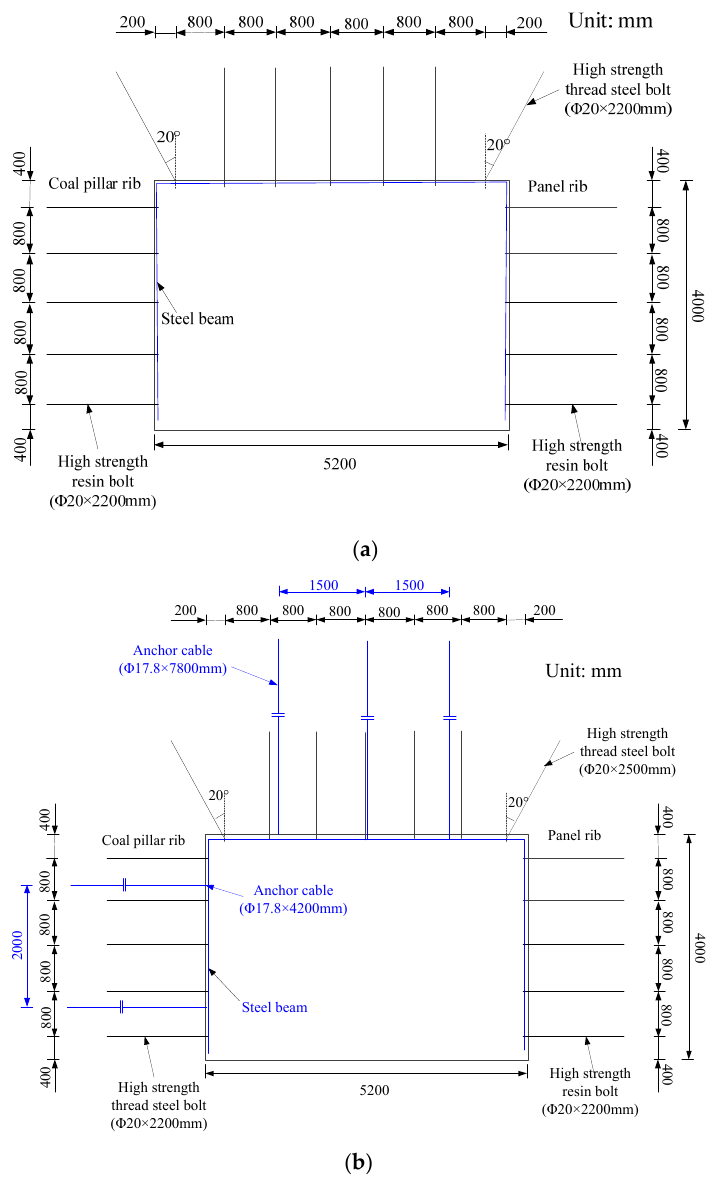
Figure 2 . The primary- and optimized-support parameters. ( a ) Primary-support parameters; ( b ) optimized-support parameters.